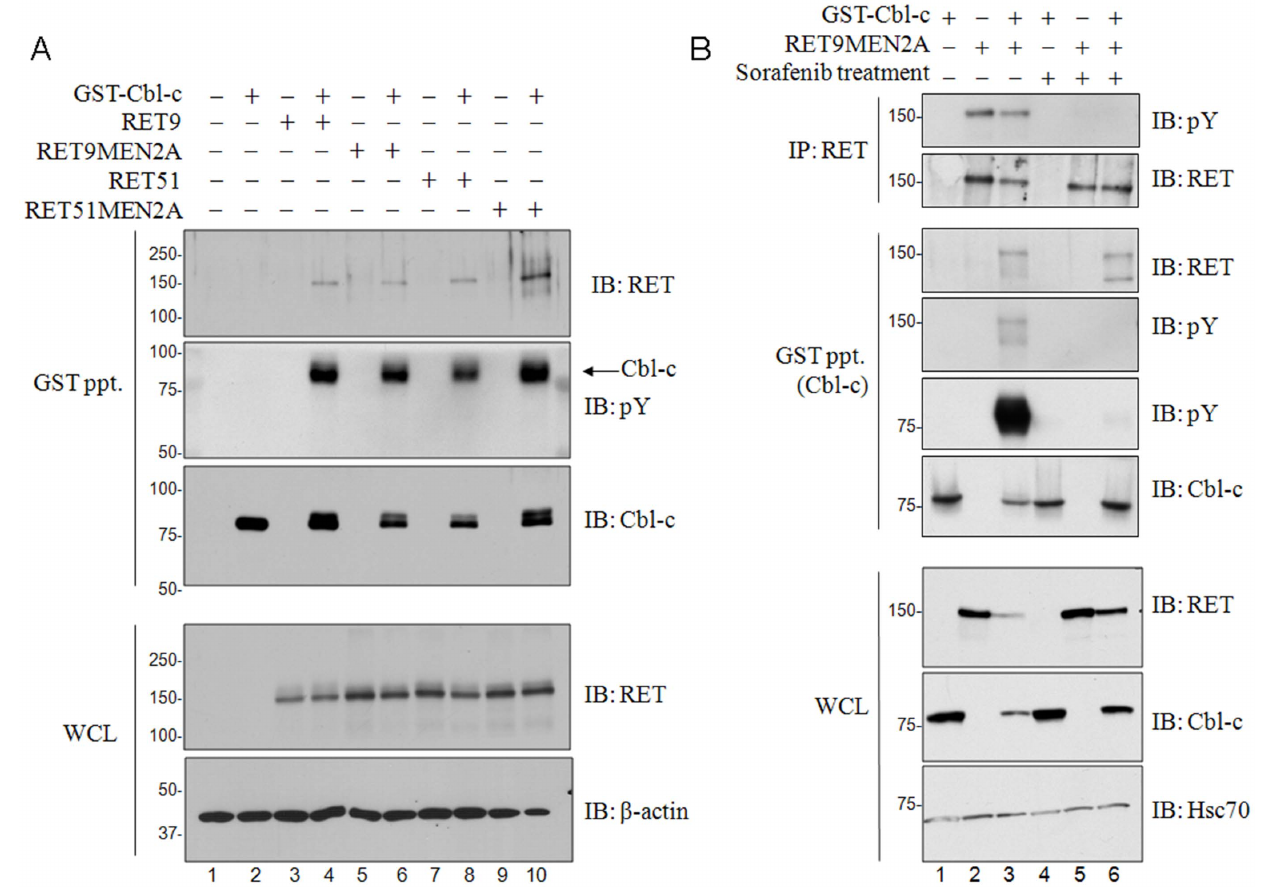
Figure 2. Cbl binds RET and MEN2A kinases. ( A ) HEK293T cells were transfected separately with pJ7 V plasmids encoding each of the following four RET kinase isoforms: RET 9, RET 51, and their MEN2A (C634R) mutant isoforms. Each was transfected both with and without GST-Cbl-c. Whole cell lysates were collected at 48h post-transfection and GST pull-downs were performed on 300 m g of whole cell lysates and immunoblotted (IB) as indicated. Whole cell lysates were immunoblotted as indicated and molecular weight standards are indicated on the left of each panel b -actin serves as a loading control. ( B ) HEK293T cells were transfected with GST-Cbl-c both with and without RET9MEN2A. Replicate plates were treated with either 500 m M Sorafenib ( + ) or DMSO as vehicle control (-) for 90m prior to collection. Whole cell lysates were immunoblotted as indicated on the right. RET immunoprecipitations were performed on 300 m g of whole cell lysates using anti-RET antibody with Protein A/G Sepharose and immunoblotted for RET and phosphotyrosine (pY) as indicated. GST pull-downs were performed, as described above, and immunoblotted (IB) for RET, phosphotyrosine (pY), and GST-Cbl-c as indicated. Molecular weight standards are indicated to the left of each panel and Hsc70 serve as loading controls.